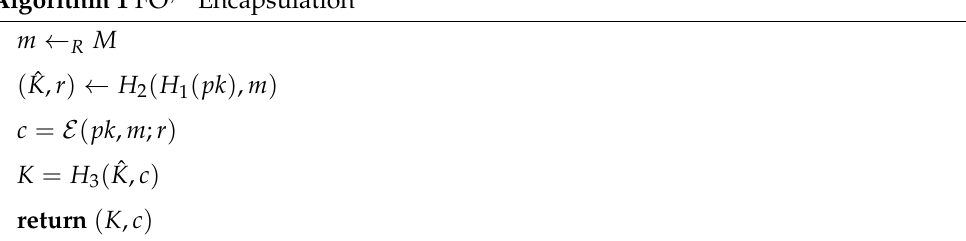
Algorithm 1 FO (cid:54)⊥